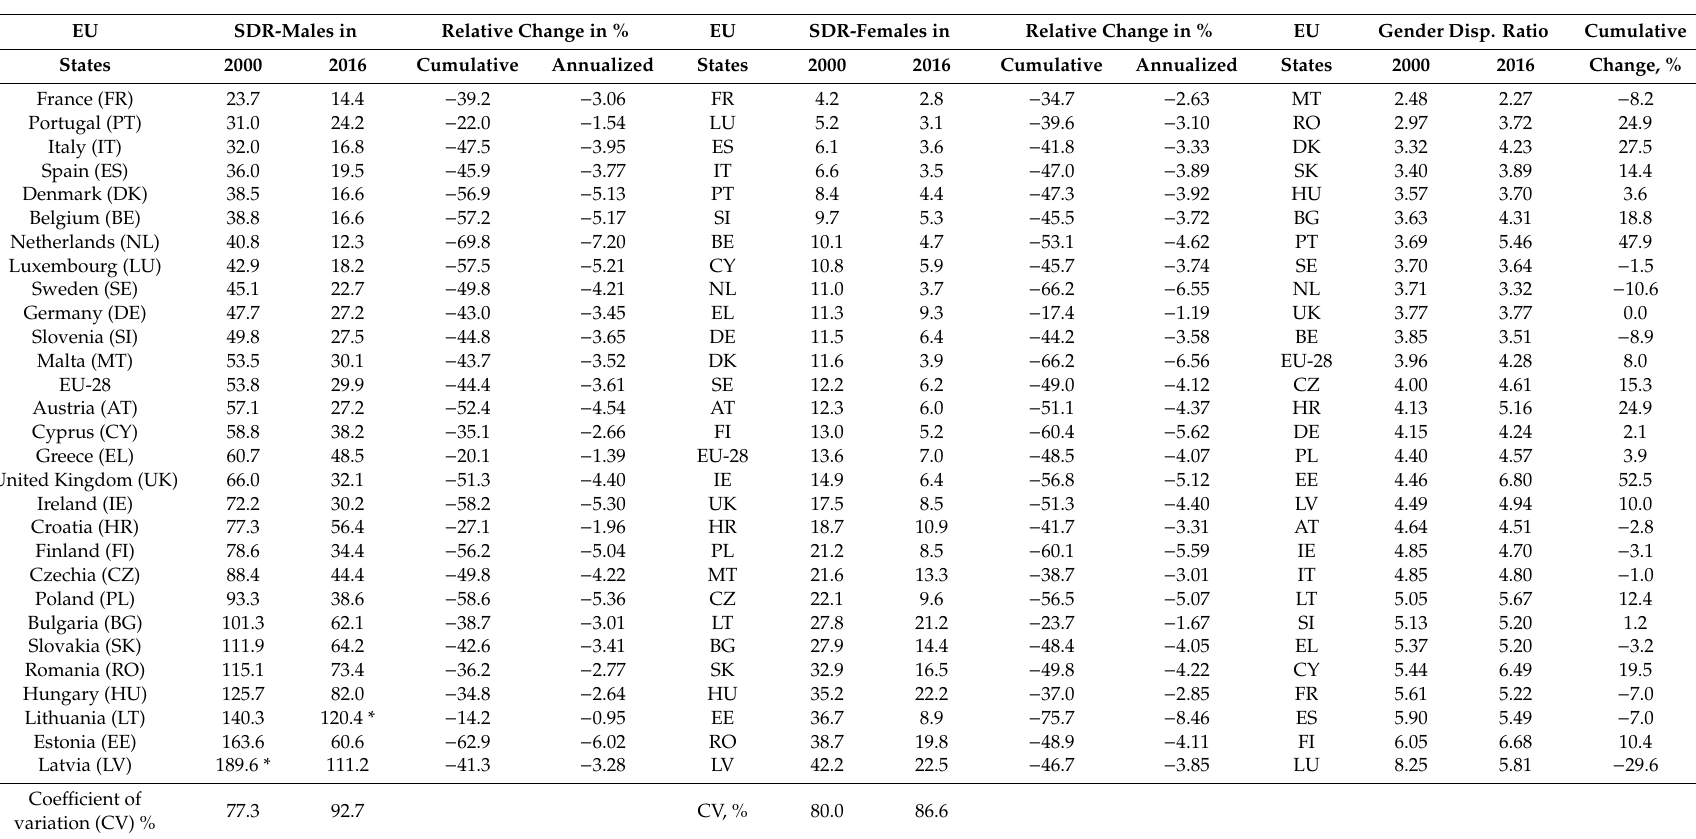
Table 3. Premature SDR for ischemic heart diseases in the EU countries in 2000 and 2016 1